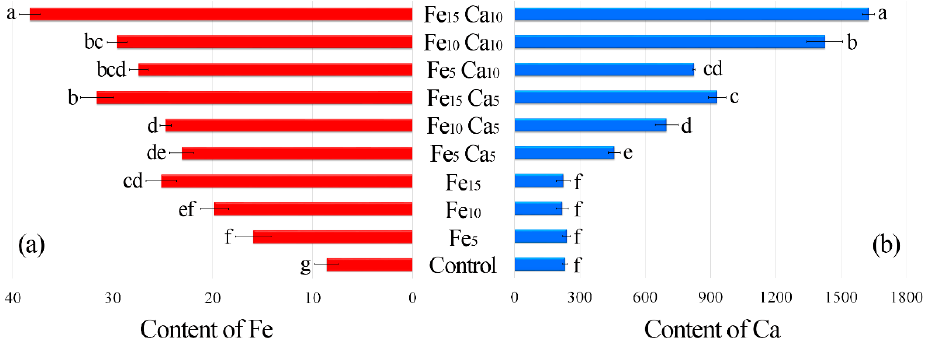
Figure 4. Content of Fe ( a ) and Ca ( b ) (mg kg − 1 DW) in mushrooms exposed to particular experimental systems. n=6, identical lower cases (a, b…) denote non-significant differences